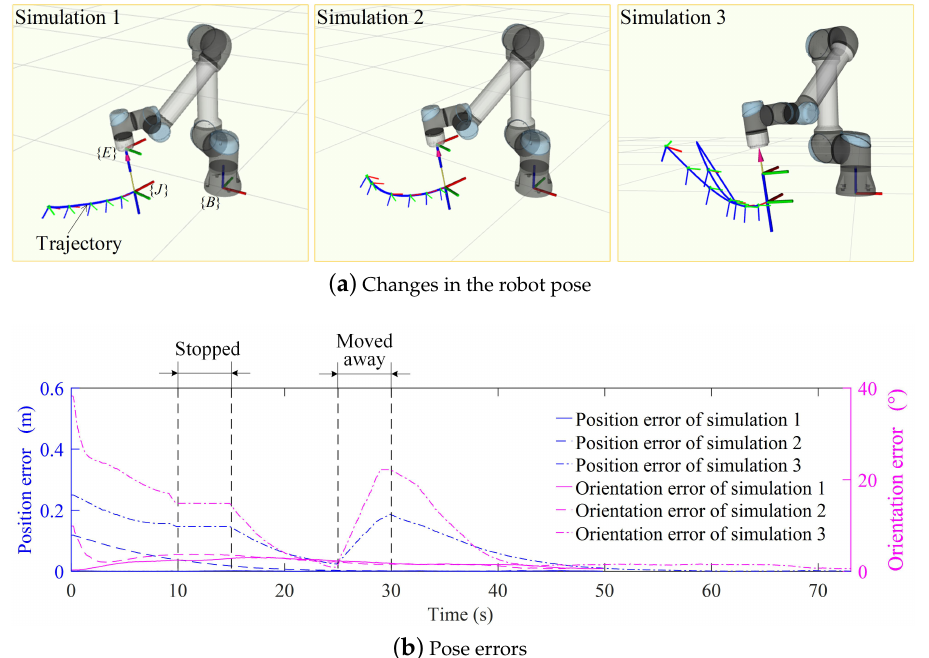
Figure 7. Simulations of the established pose DS. The robot starts moving from different poses for the three simulations. The trajectories of the three simulations are shown in ROS Rviz visualizer. The position and orientation errors of three simulations are